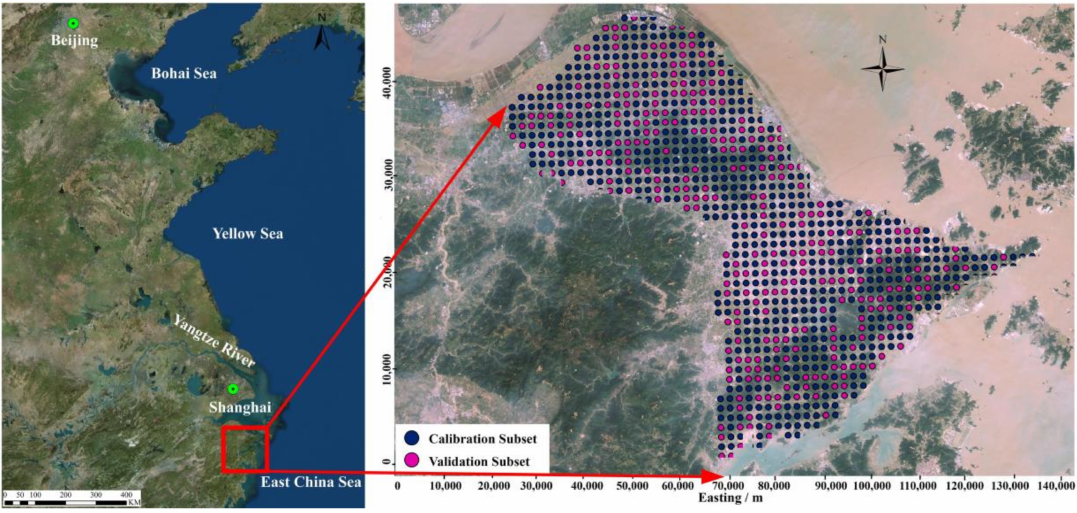
Figure 1. Map of the study